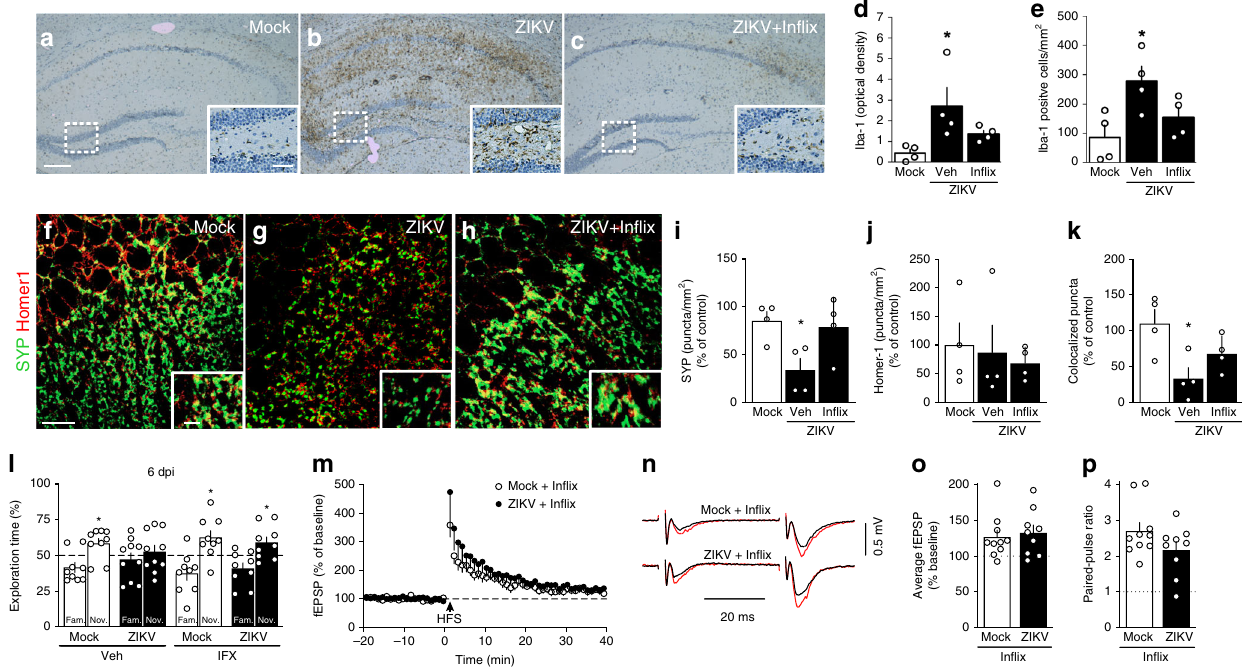
Fig. 6 TNF- α mediates microglial activation, ZIKV-induced synapse and memory impairment. Adult Swiss mice received an i.c.v. infusion of 10 5 PFU ZIKV or mock medium and were treated (or not) with In fl iximab (In fl ix; 0.2 μ g/day, from 2 to 6 dpi, i.c.v.). a – c Representative images of Iba-1 immunolabeling in hippocampi of mock-infused ( a ), ZIKV-infected mice treated with vehicle ( b ), or ZIKV-infected mice treated with In fl iximab ( c ) at 10 dpi. Scale bar = 200 μ m, inset scale bar = 50 μ m. d , e Integrated Iba-1 optical density ( d ) and number of Iba-1-positive cells ( e ) in the hippocampus ( d F(2,9) = 4.629, * p = 0.043; e F(2,9) = 5.254, * p < 0.0327, one-way ANOVA followed by Bonferroni, N = 4 mice/group). f – h Representative images of the CA3 hippocampal region of mock-infused ( f ), ZIKV-infected mice treated with vehicle ( g ), or ZIKV-infected mice treated with In fl iximab ( h ) immunolabeled for synaptophysin (SYP, green) and Homer1 (red). Scale bar = 25 μ m, inset scale bar = 5 μ m. i – k SYP ( i ), Homer1 ( j ), and colocalized SYP/Homer1 puncta ( k ). ( i F(2,9) = 4.917, * p = 0.0364, k F(2,9) = 5.682, * p = 0.0166, one-way ANOVA followed by Bonferroni ’ s; N = 4 mice/group). l Mice were tested in the NOR test at 6 dpi ( l : t = 2.364 * p = 0.0456 for mock/Veh, t = 2.688 * p = 0.0276 for mock/In fl ix, t = 2.310 * p = 0.0497 for ZIKV/In fl ix; one-sample Student ’ s t- test compared to the chance level of 50%; N = 10 (ZIKV) and 9 (other groups); data represent one of two independent experiments). m – p In fl iximab prevents ZIKV-induced impairment in LTP in dorsal hippocampal CA3 area. m Means ± SEM of slopes of fi eld excitatory post-synaptic potentials (fEPSPs) evoked in CA3 by mossy fi ber stimulation, before and after high-frequency stimulation (HFS), in slices from mock- or ZIKV-infused mice treated with in fl iximab. n Representative fEPSPs before (black) and 35 – 40 min after (red) HFS. o Average fEPSP slopes 35 – 40 min post-HFS. p Baseline paired- pulse amplitude ratios. (N = 10 slices from 7 mock-infused and 9 slices from 6 ZIKV-infected mice). Bars represent means± SEM. Symbols correspond